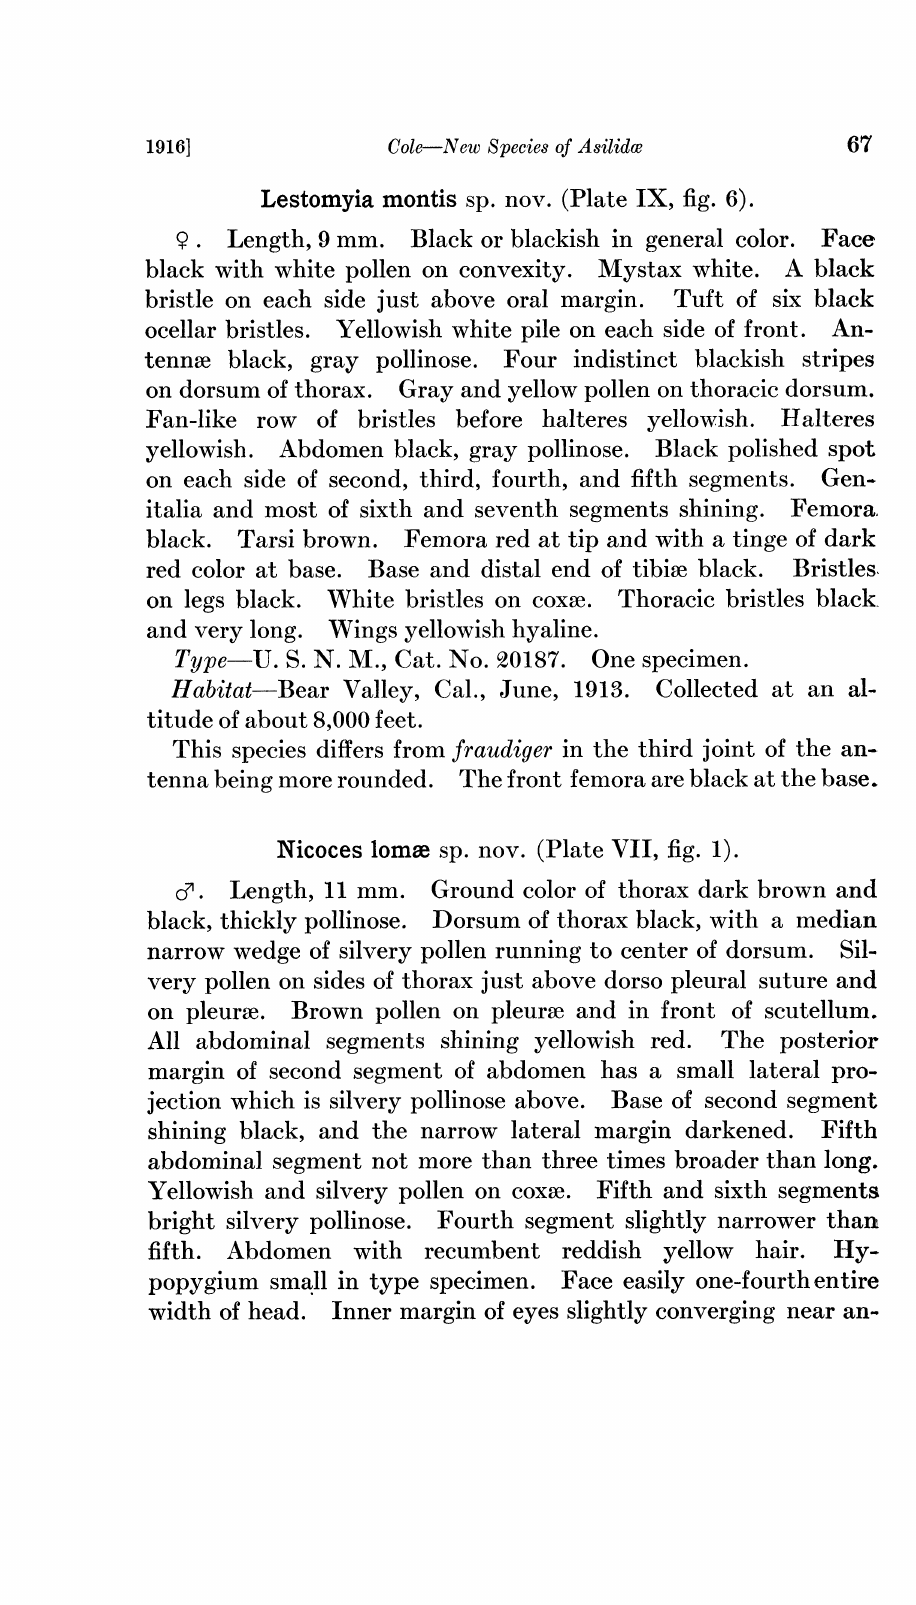
Dorsum of thorax black, with a median narrow wedge of silvery pollen running to center of dorsum. very pollen on sides of thorax just above dorso pleural suture and on pleurae. Brown pollen on pleurm and in front of scutellum. All abdominal segments shining yellowish